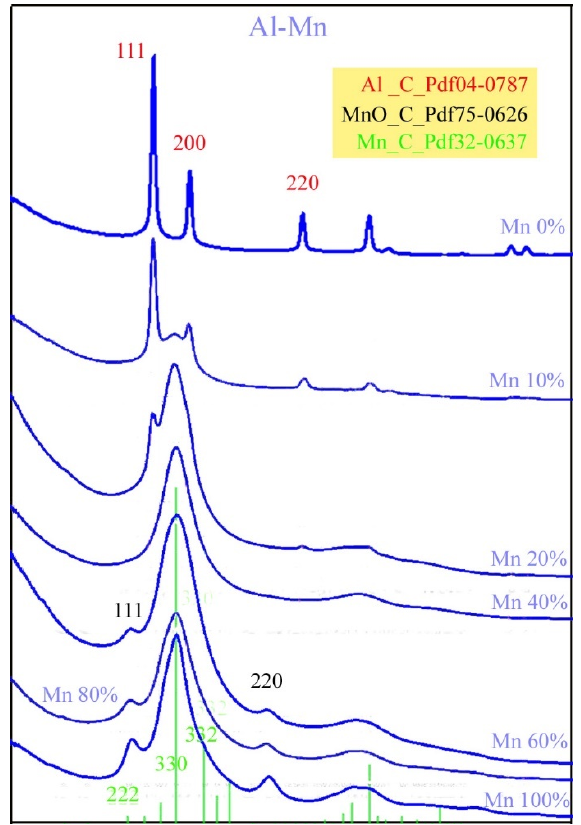
Figure 6. SAED intensity distributions representing the phases of the AlMn layer depicted in Figure 5 with various compositions obtained from a single μ‐ combinatorial TEM sample deposited at room temperature. Green, black, and red indices show the peak positions of cubic Mn, MnO, and Al phases, respectively.